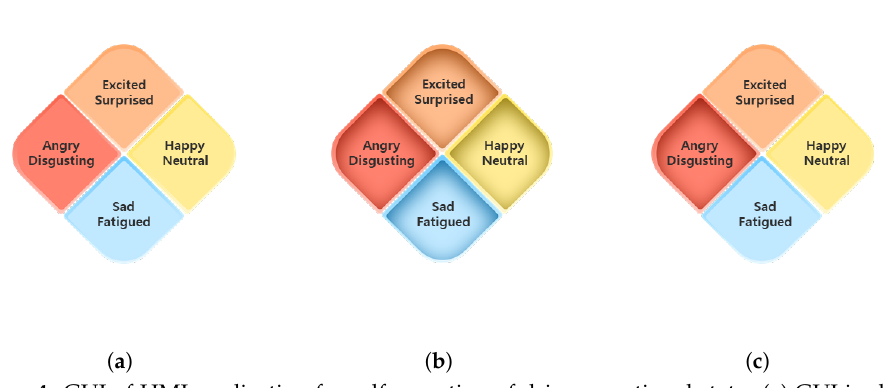
Figure 4. GUI of HMI application for self-reporting of driver emotional state. ( a ) GUI in default; ( b ) GUI in touch; ( c ) GUI example where “Angry|Disgusting” state is